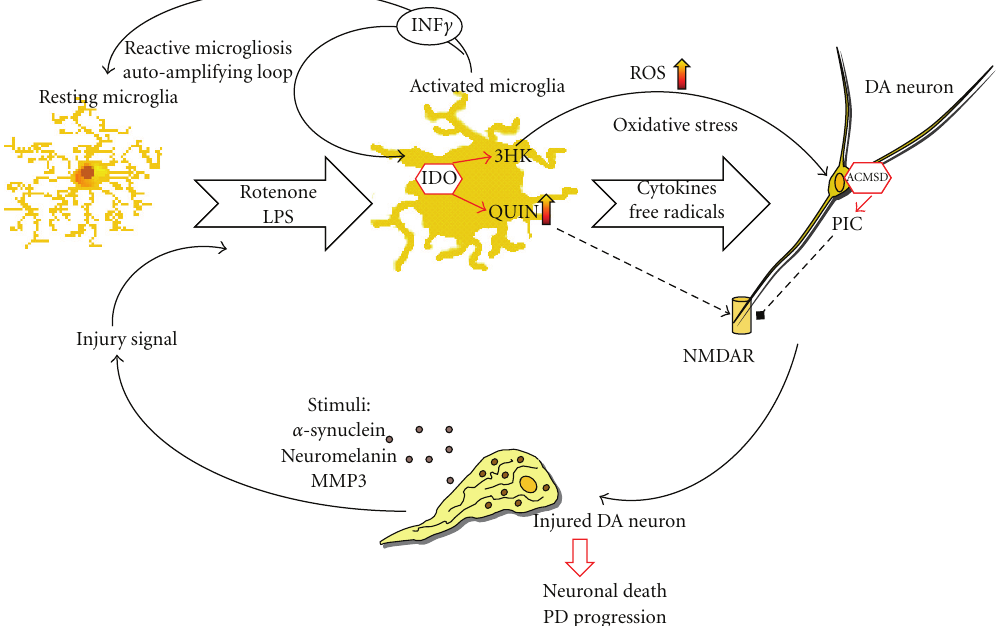
Figure 5: The possible role of Kynurenine pathway involvement in dopaminergic neurodegenerative process through microglia activation: Parkinson’s disease is associated with chronic activation of microglia, which also can be induced by LPS or Rotenone treatments. Classic microglia activation release neurotoxic substances including reactive oxygen species (ROS) and proinflammatory cytokines as INF- γ , potent activator of Kynurenine pathway (KP). KP in activated microglia leads to upregulation of 3HK and QUIN. 3HK is toxic primarily as a result of conversion to ROS. The combined e ff ects of ROS and NMDA receptor-mediated excitotoxicity by QUIN contribute to the dysfunction of neurons and their death. However, picolinic acid (PIC) produced through KP activation in neurons, has the ability to protect neurons against QUIN-induced neurotoxicity, being NMDA agonist. Microglia can become overactivated, by proinflammatory mediators and stimuli from dying neurons and cause perpetuating cycle of further microglia activation microgliosis. Excessive microgliosis will cause neurotoxicity to neighbouring neurons and resulting in neuronal death, contributing to progression of Parkinson’s